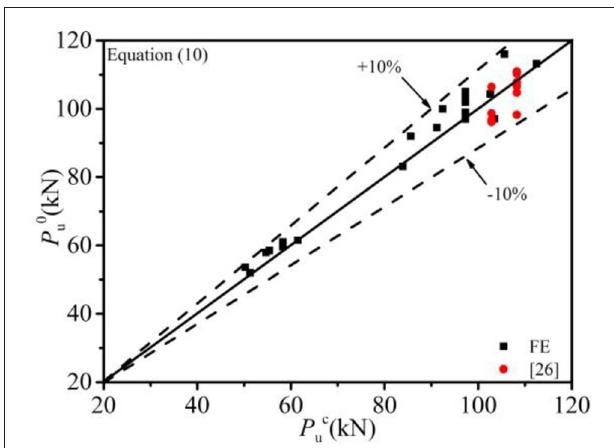
FIGURE 13 | Comparison of the calculated results with the FE example results and the tested (Yang et al., 2020).